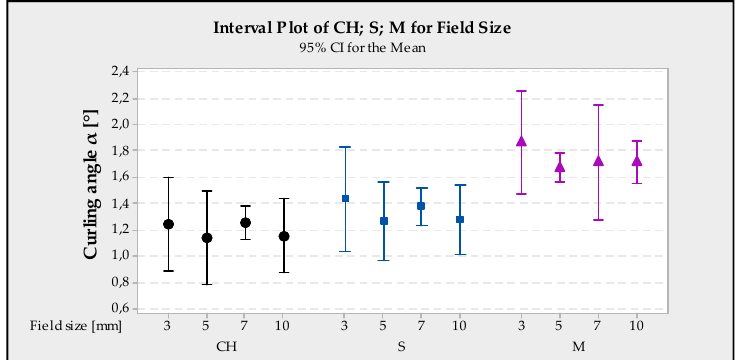
Figure 8. Interval plot of CH, S, M for field size.